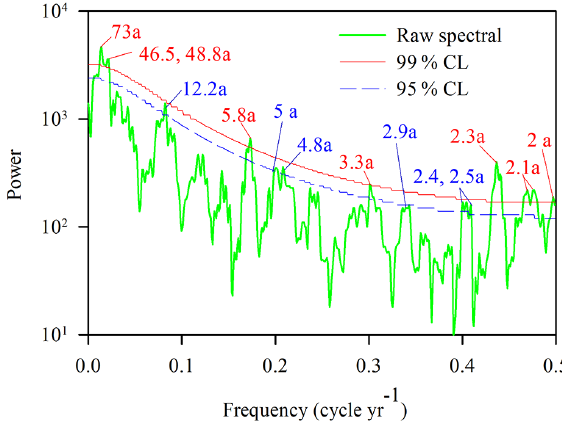
Figure 6. Multi-taper method power spectrum of the reconstructed PDSI during the period 1751–2010. The 95% and 99% confidence levels relative to red noise are shown and the numbers refer to the significant period in